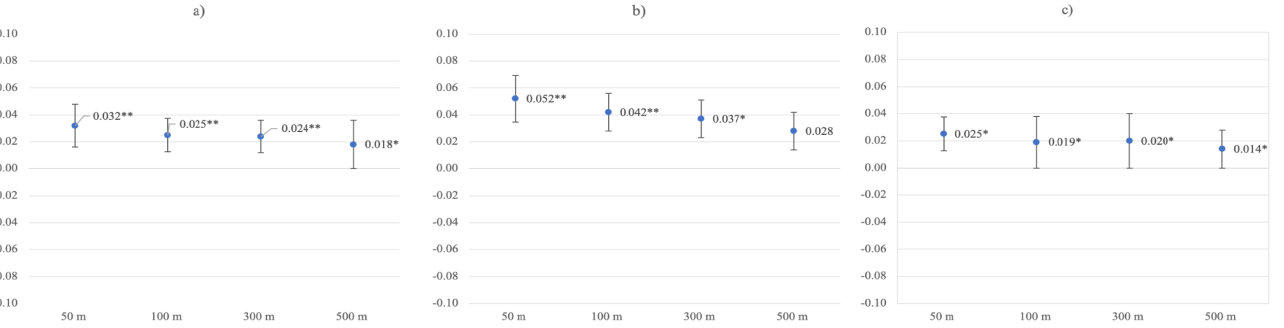
Figure 5. Greenspace ß coefficients with standard errors for unadjusted life satisfaction models in the ( a ) whole sample, ( b ) non-working group, and ( c ) working group. * Statistical significance at p ≤ 0.05. ** Statistical significance at p ≤ 0.01.